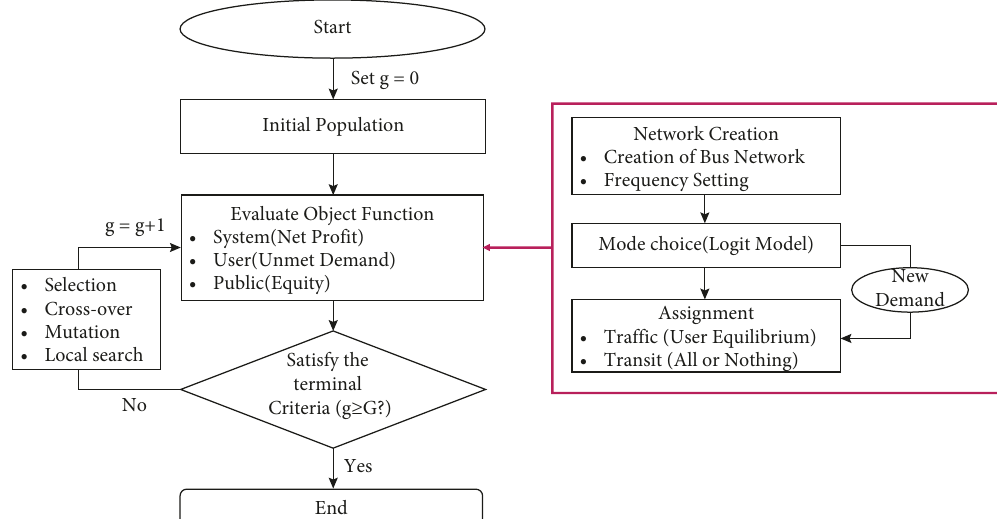
Figure 1: Overview of transit network optimization.